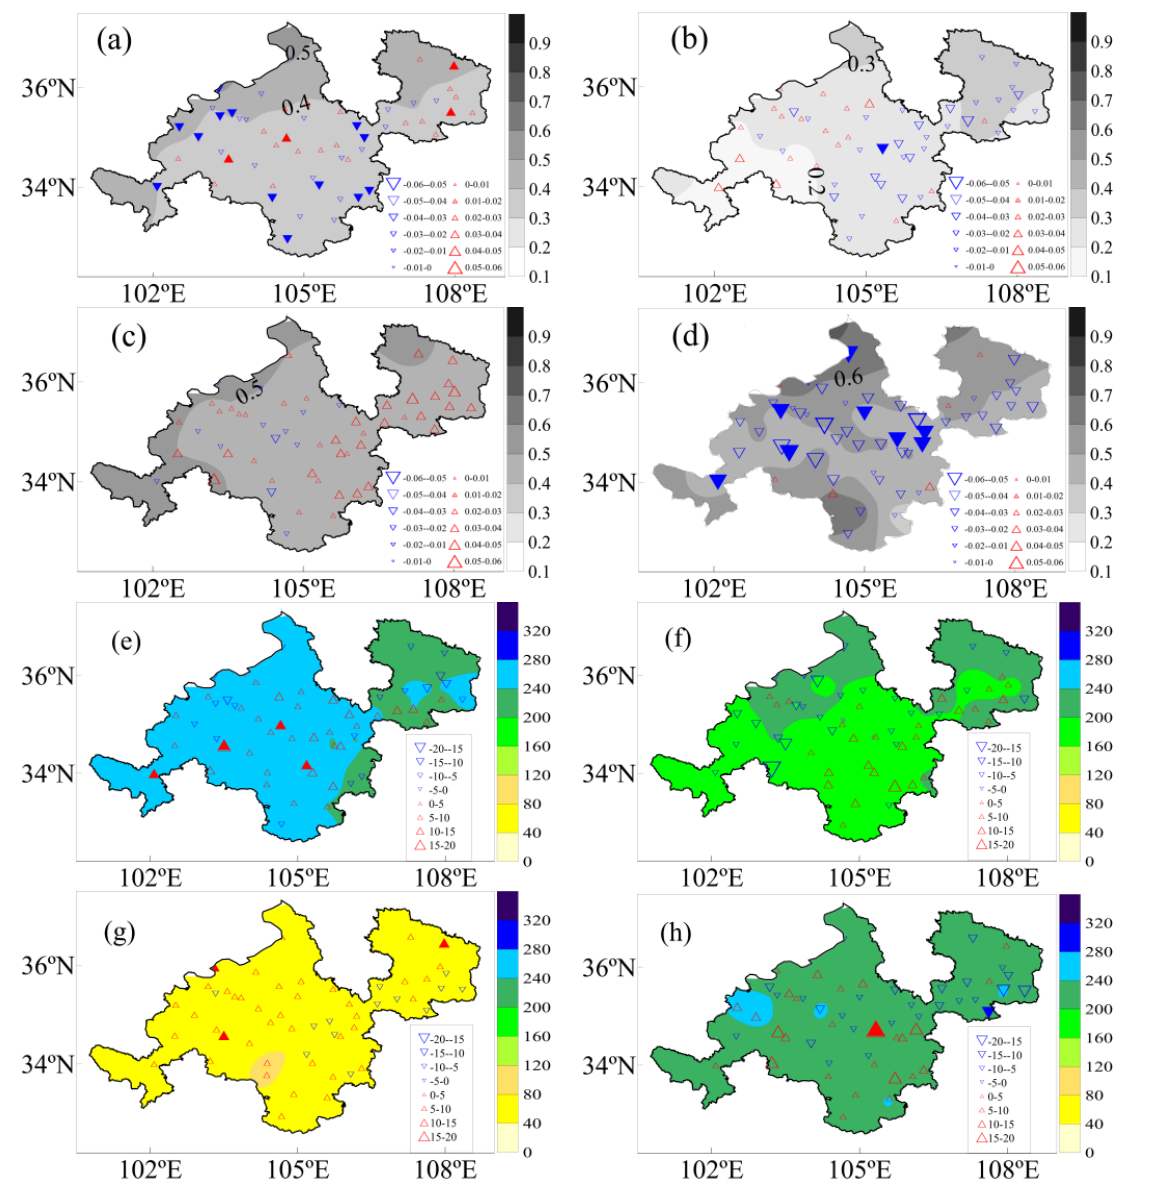
Figure 8. Average precipitation heterogeneity and its trend in each season. (( a – d ) are PCD in spring, summer, autumn, 1 and winter, respectively; ( e – h ) are PCP in spring, summer, autumn, and winter, respectively; solid indicates the trend is significant at the 0.05 level based on the Student’s t